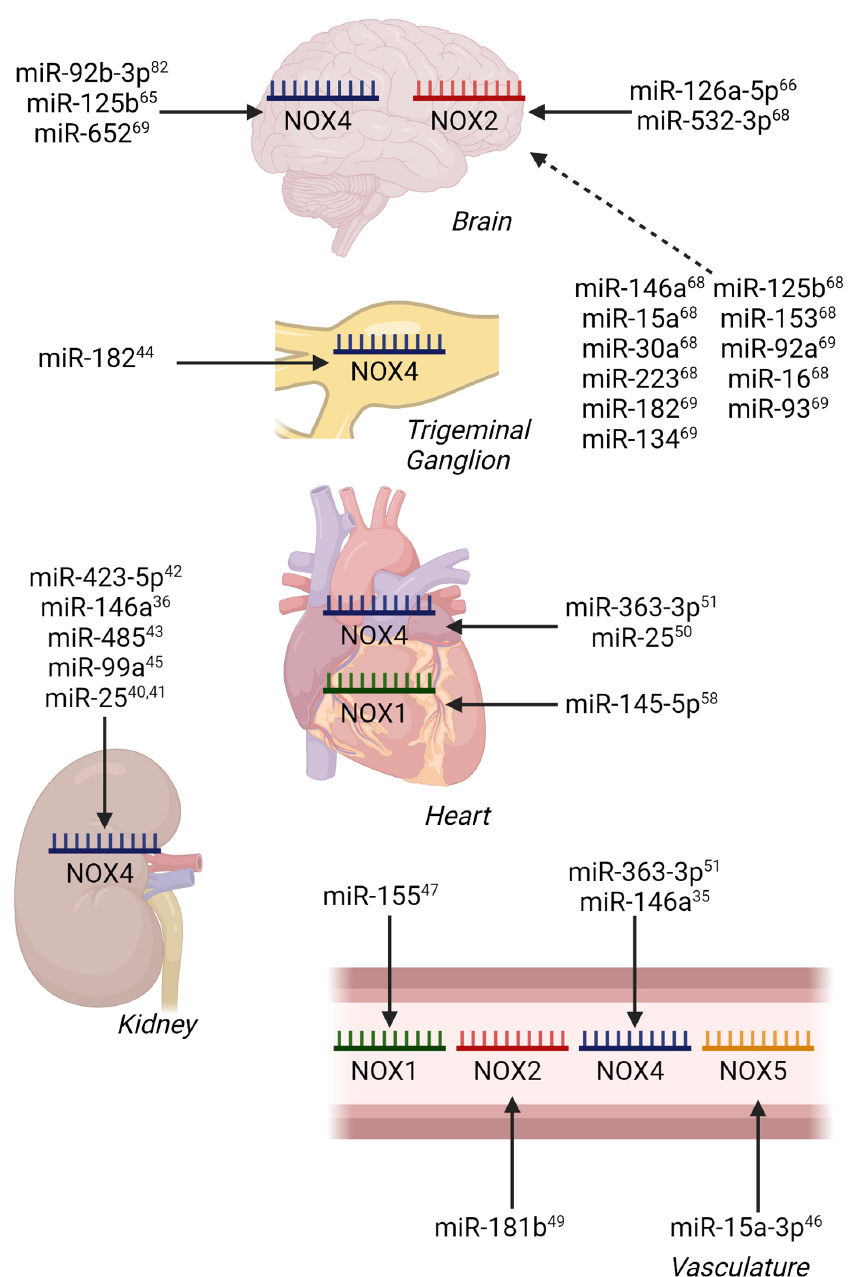
Figure 2. miRNA Regulation of NOX Isoforms in Models of Vascular, Metabolic, and Is- chemia/Reperfusion Injury by Tissue. Confirmed miRNA-mRNA interactions are indicated by solid arrows, while predicted miRNA-mRNA interactions are indicated by dashed arrows. Super- script numbers indicate associated